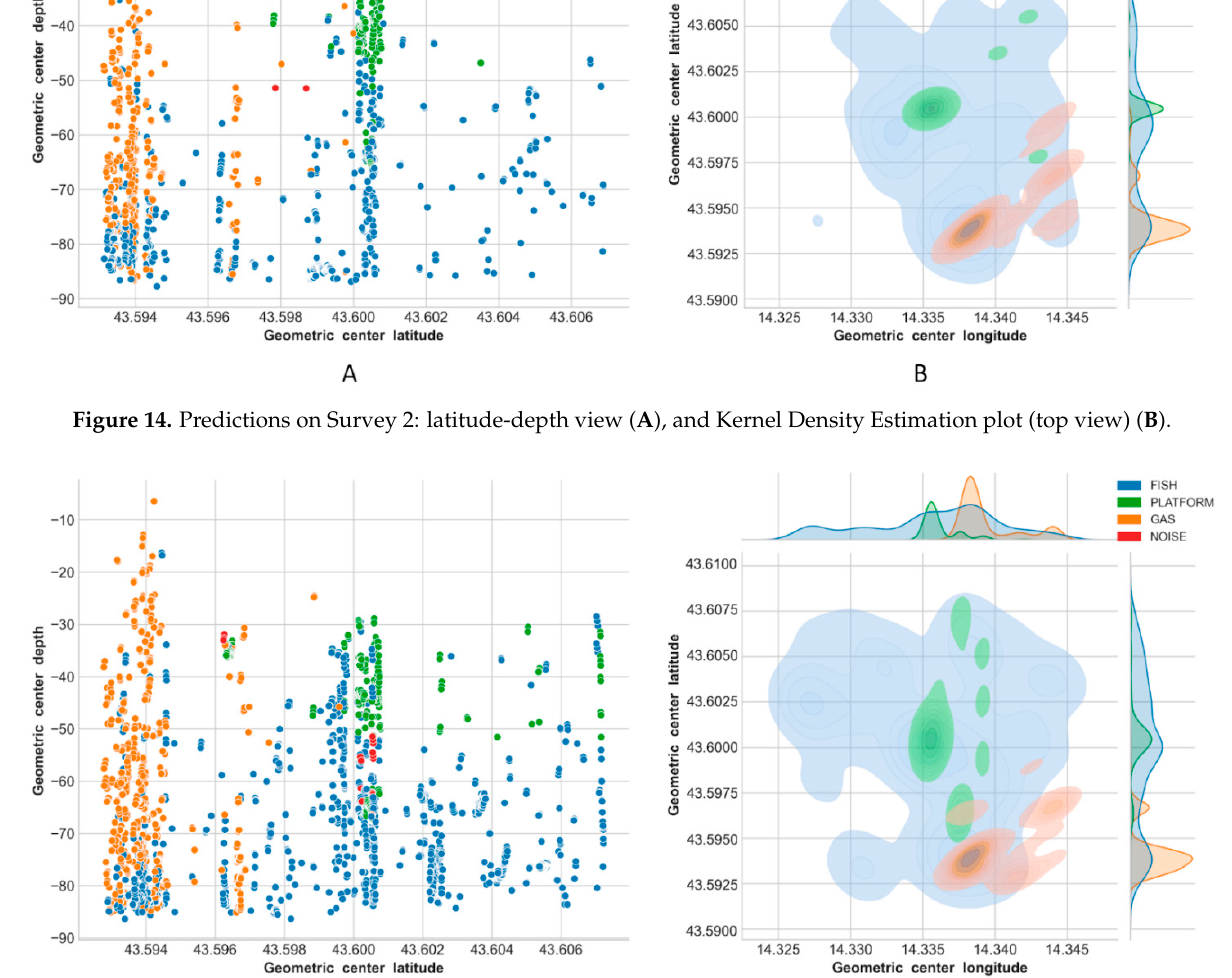
Figure 15. Predictions on Survey 3: latitude-depth representation ( A ), and Kernel Density Estimation plot ( B ).